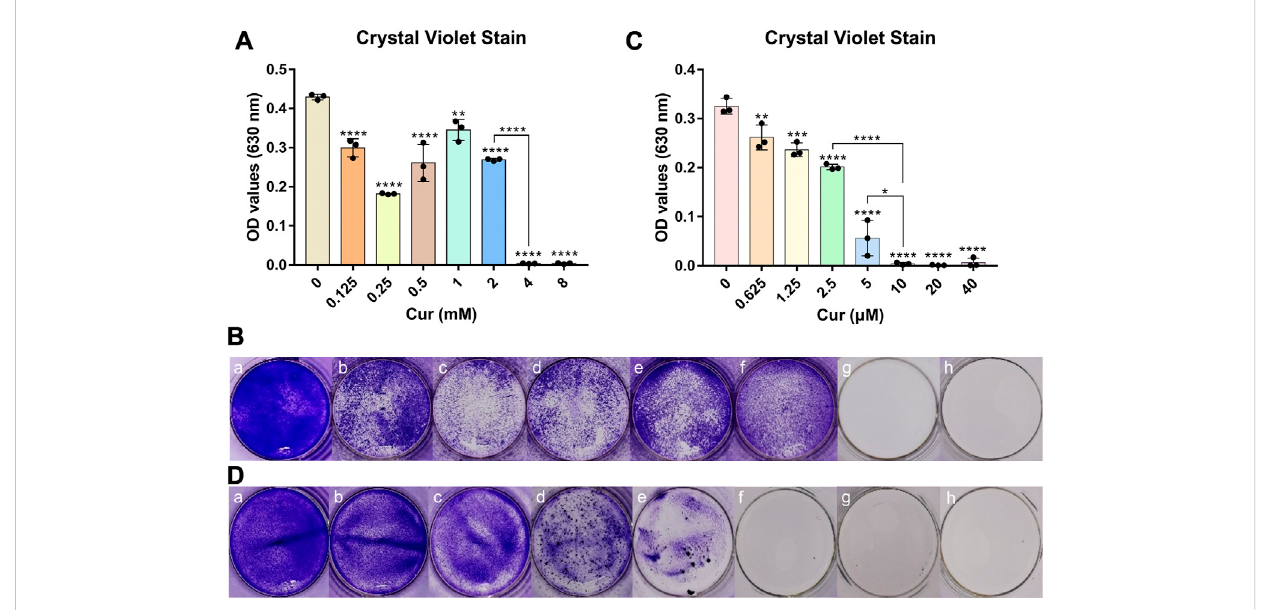
FIGURE 3 (A) Antibacterial properties ofdifferentconcentrations of curcumin without photoactivation. (B) Crystal violet staining imagesof curcumins without photoactivation effects of Cur (mM) with (a) 0, (b) 0.125, (c) 0.25, (d) 0.5, (e) 1, (f) 2, (g) 4, and (h) 8. (C) Antibacterial property of different concentrations of curcumin with photoactivation. (D) Crystal violet staining images with photoactivation effects of Cur ( μ M) with (a) 0, (b) 0.625, (c) 1.25, (d) 2.5, (e) 5, (f) 10, (g) 20, and (h) 40. Statistical signi fi cance was calculated via two-tailed Student ’ s t -test. Data are presented as mean values